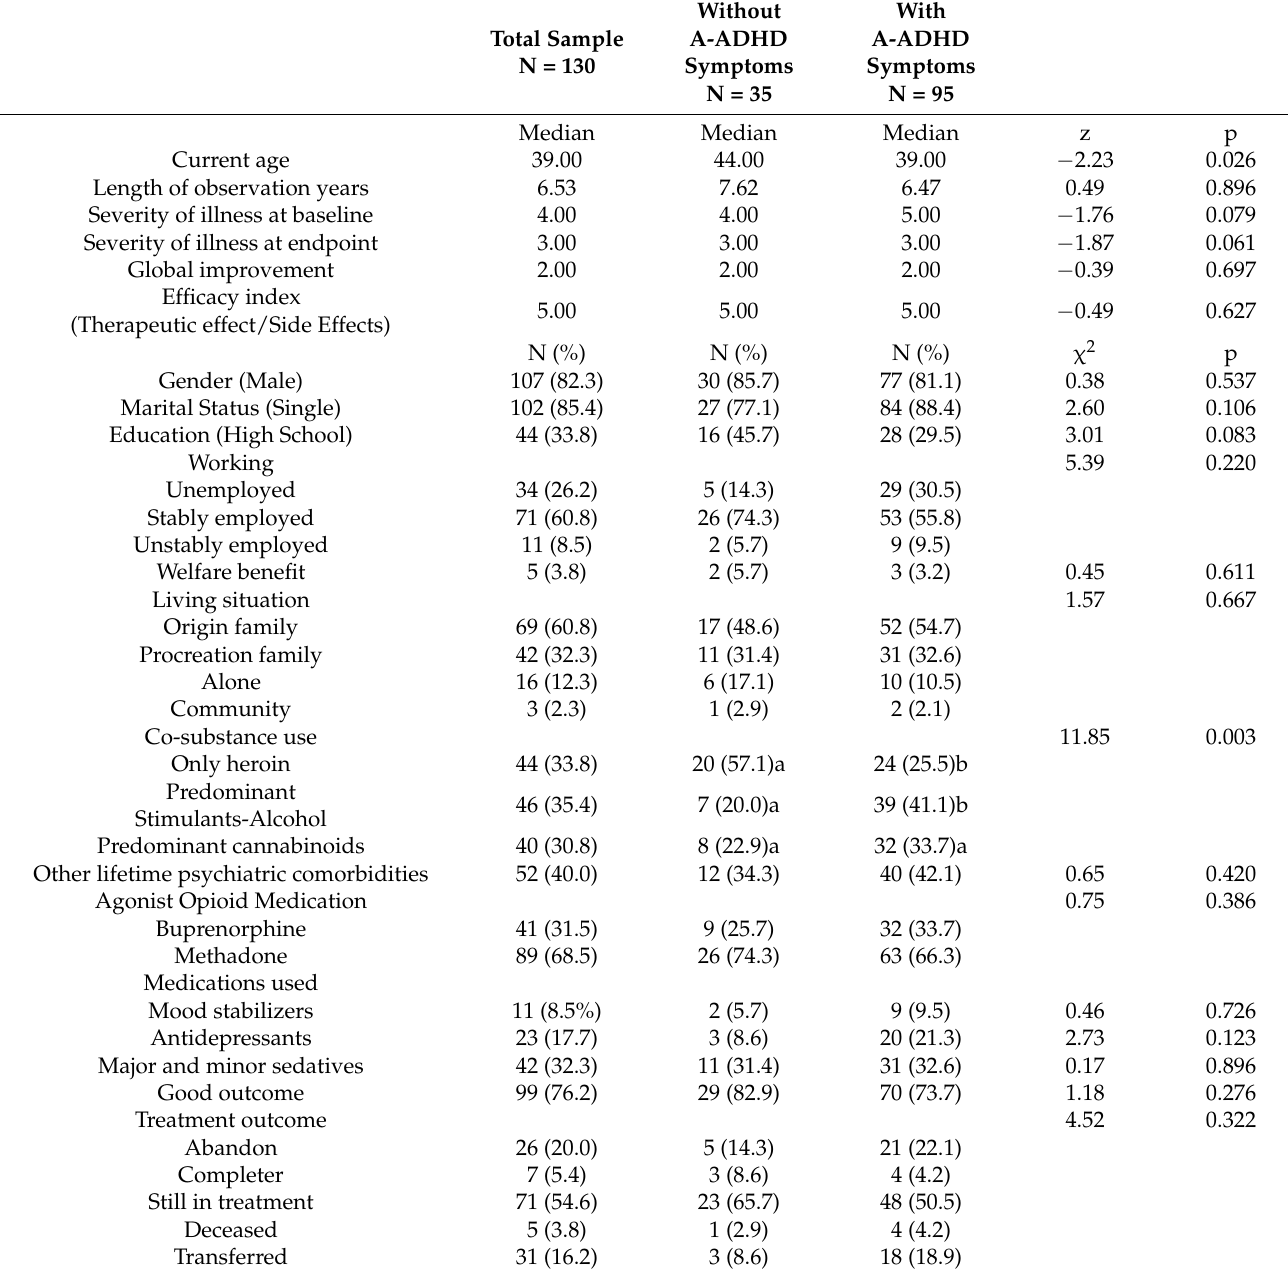
Table 1. Differential characteristics of Heroin Use Disorder patients according to the co-presence of A-ADHD symptoms.